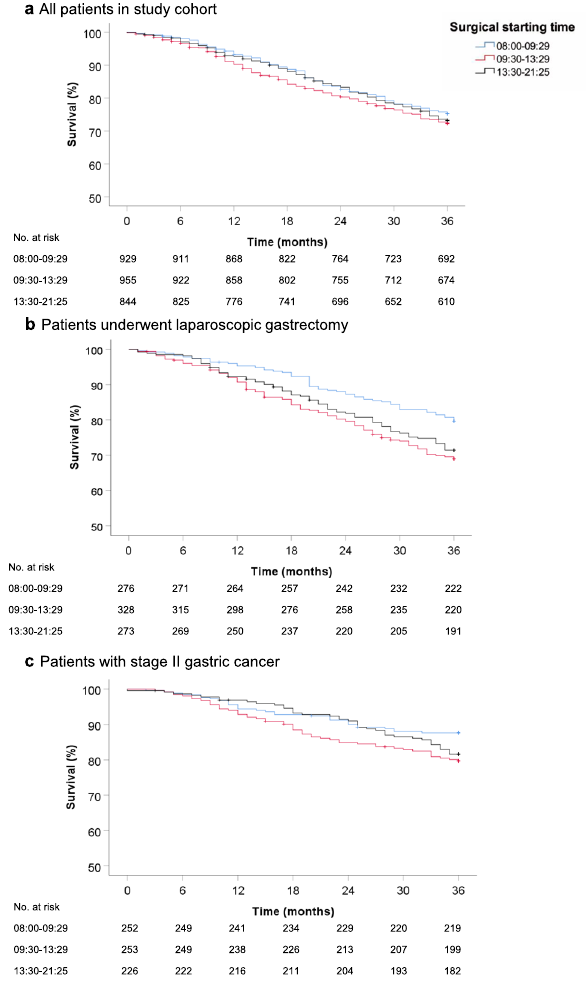
Figure 2. Kaplan–Meier overall survival curves in gastric cancer patients who underwent gastrectomy by surgical starting time of the day: ( a ) All patients; ( b ) Patients who had undergone laparoscopic gastrectomy; ( c ) Patients with stage II gastric